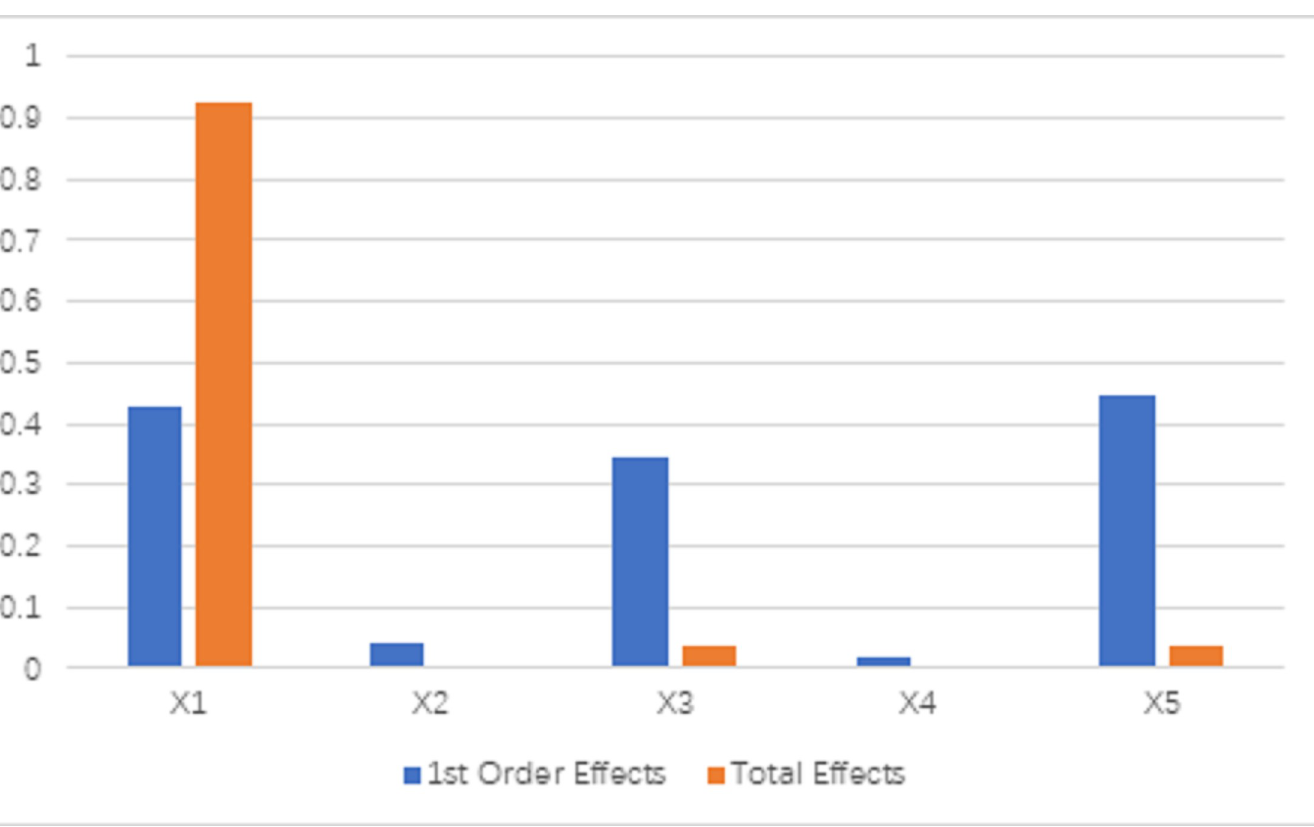
Fig 7. First-order effects and total effects of the five parameters using Sobol’s method of sensitivity analysis.